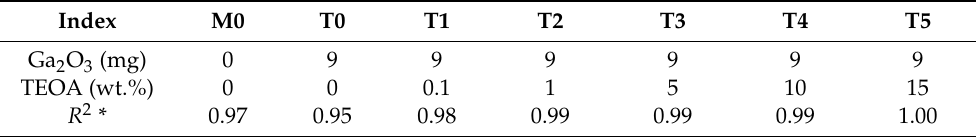
Figure 2. ( a ) Photocatalytic degradation kinetics with a linear fitting for MB reduction at different TEOA concentrations (T0–T5), including without TEOA and Ga 2 O 3 (M0). ( b ) pH value of the MB solution as a function of the TEOA concentration. The rate constant k (min −1 ) of MB reduction as a function of ( c ) the TEOA concentration (T0–T5) and ( d ) the pH changes (8.0–10.5) induced by the addition of ammonia solution. Table 1. Experimental conditions with different TEOA